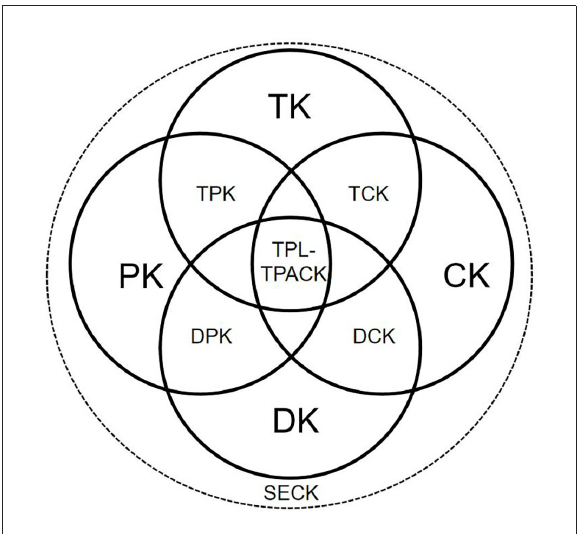
FIGURE3 TDL-TPACK framework for